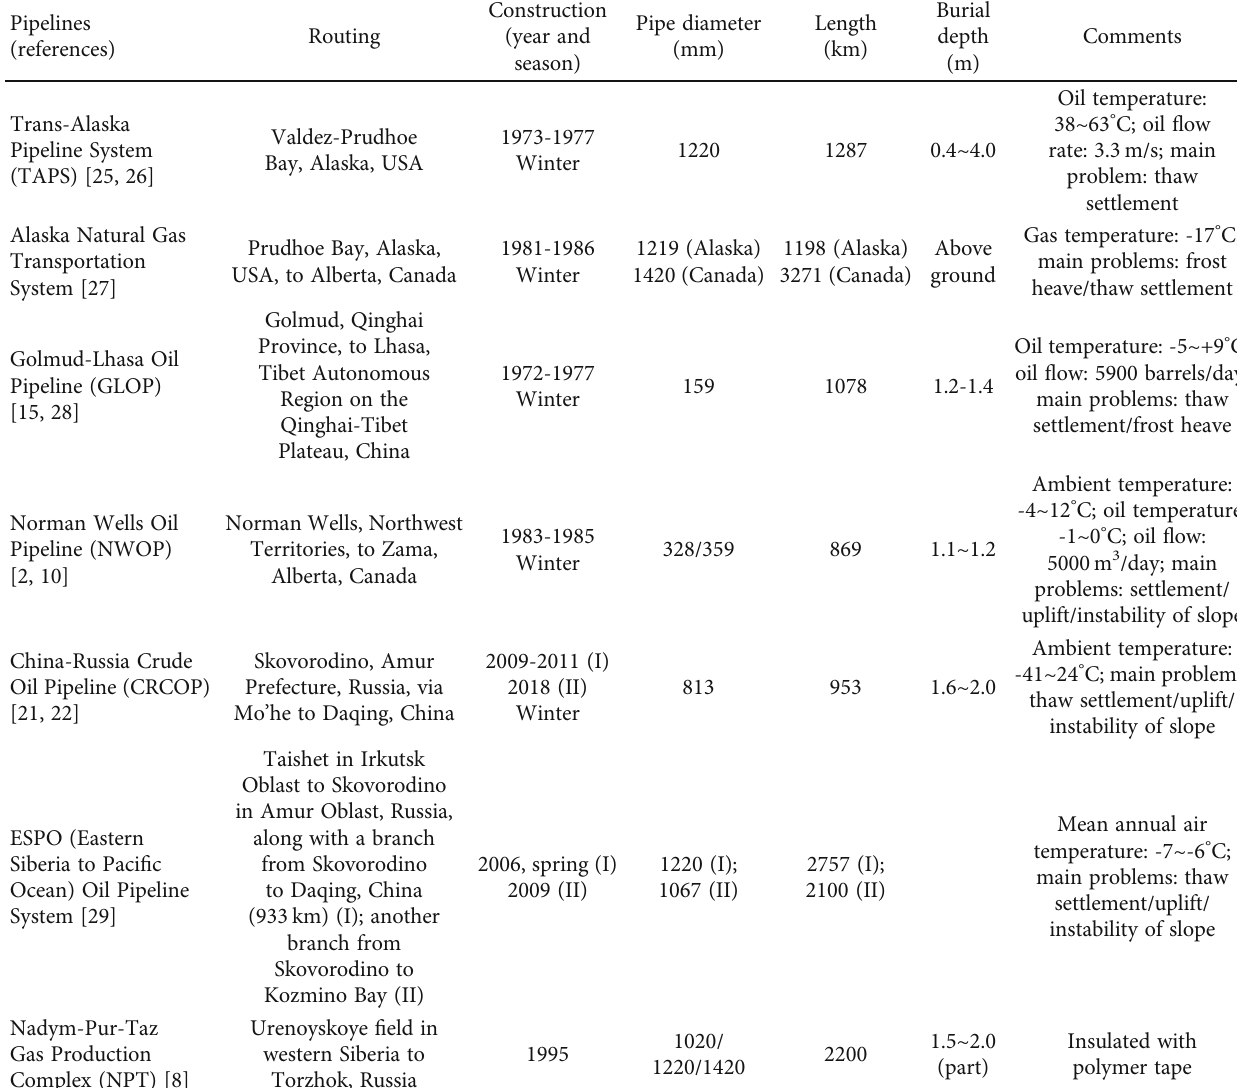
Table 1: Features of main energy pipelines in permafrost